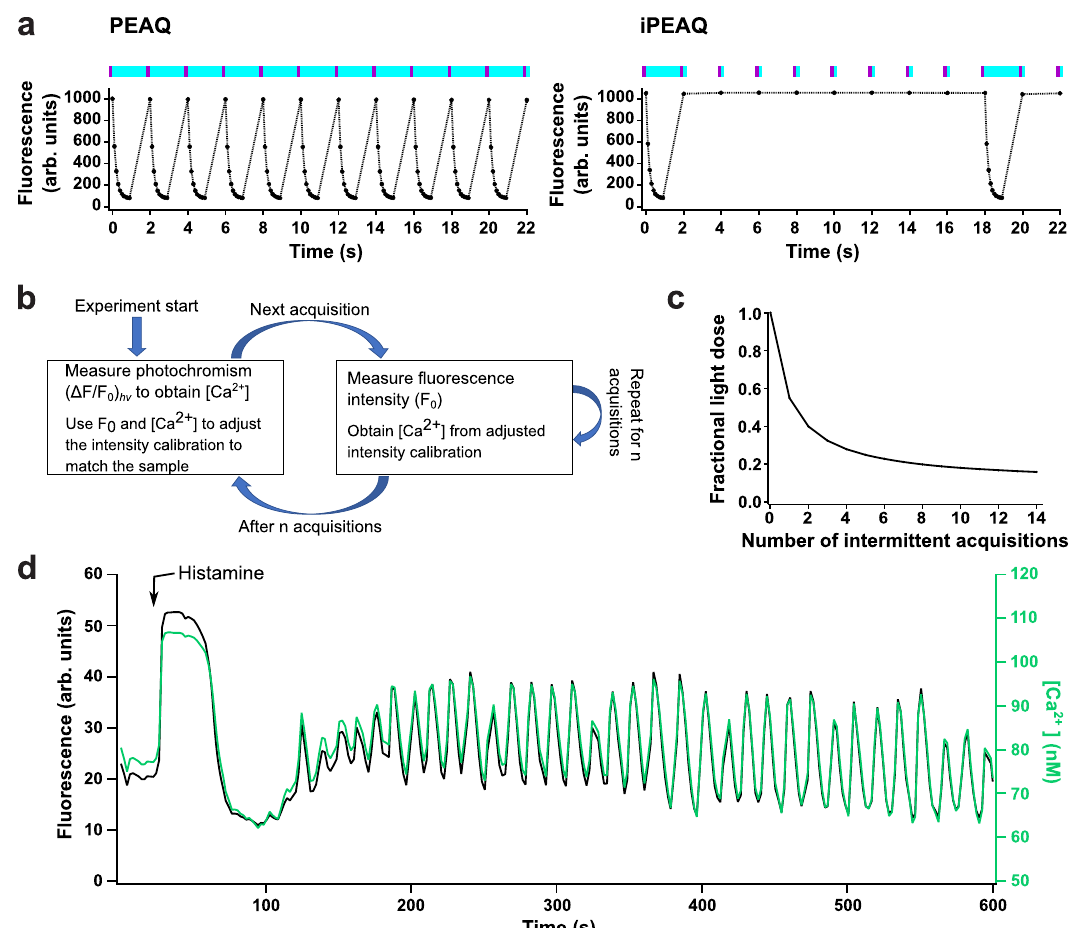
Fig. 4 iPEAQ biosensing with intermittent calibration. a Comparison of the irradiation procedure of PEAQ biosensing using repeated photochromism cycles (left), and iPEAQ biosensing using intermittent photochromism cycles (right). b Schematic overview of the intermittent calibration methodology. c Fraction of the light dose that can be saved using iPEAQ as a function of the number of intensiometric acquisitions per photochromism cycle. (cid:1) (cid:3) trace (green) of a single GCaMP6s-Q-expressing HeLa cell after stimulation with 25 μ M histamine d Fluorescence intensity F 0 (black) and Ca 2 þ